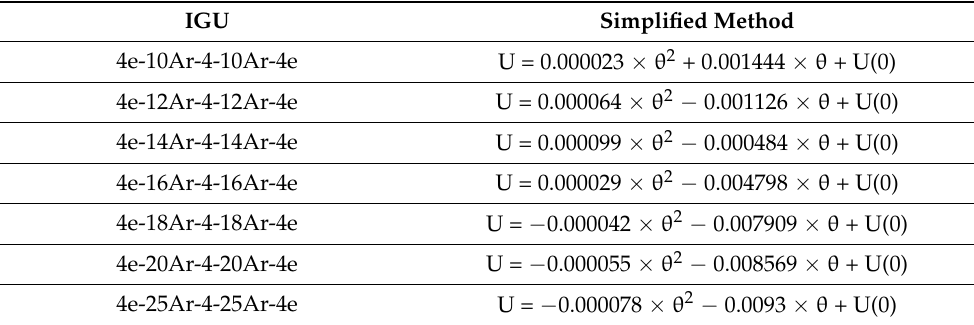
Table 5. Simplified method for recalculation of declared thermal transmittance values U(0) at 0 ◦ C to values at lower external temperatures θ e , ◦ C (triple-glazed IGUs).